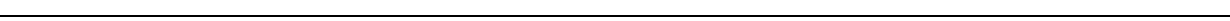
Fig. 3 Lefty1 expression in L1 epi cells is induced by Nodal. a An E3.2 embryo harboring both Lefty1(mVenus) and Nodal(Tomato) BAC transgenes was cultured for 5 h, with fl uorescence of mVenus and Tomato being examined at the indicated times. Nodal expression began in two cells at 3.5 h (magenta arrowheads), with these two cells becoming positive for Lefty1 expression by 4.75 h (green arrowheads). b Schematic illustration of mRNA injection experiments in ( c ) and ( d ). mTomato mRNA (encoding a membrane-localized Tomato) was injected with or without Nodal mRNA into a single cell of E3.2 embryos harboring the Lefty1(mVenus) BAC transgene. Embryos were examined for mTomato and mVenus immuno fl uorescence 6 h after mRNA injection. c Embryos injected with both mTomato and Nodal mRNAs. mVenus is expressed in the injected cell (upper panel) or in a neighboring cell of the injected cell (lower panel). d Two embryos injected with mTomato mRNA alone. mTomato + and mVenus + cells (arrowheads) do not overlap. e Summary of the location of the mVenus + cell relative to the injected cell for experiments similar to that in c and d . f E3.2 embryos harboring the Lefty1(mVenus) BAC transgene were injected with mTomato mRNA alone or together with Nodal mRNA, allowed to develop in utero, recovered at E4.5, and examined for Lefty1(mVenus) and GATA6 expression. Note that there is no substantial difference in the number of Lefty1 -expressing cells between the two types of injected embryos (Supplementary Fig. 3b, c). g E3.2 embryos harboring A 7 -Venus were injected with mTomato mRNA alone or together with Nodal mRNA and were examined for GATA6 and Venus expression after 6 h. When mTomato mRNA alone was injected, the Venus + cell was randomly located relative to the injected cell (lower panel). However, when Nodal mRNA was co-injected, the injected cell or a neighboring cell was positive for Venus (upper panel). h An E3.2 embryo co-injected with excess Nodal mRNA (200 ng/ µ l) and with mTomato mRNA was immunostained for Nodal at 6 h after mRNA injection. Scale bar , 50 μ